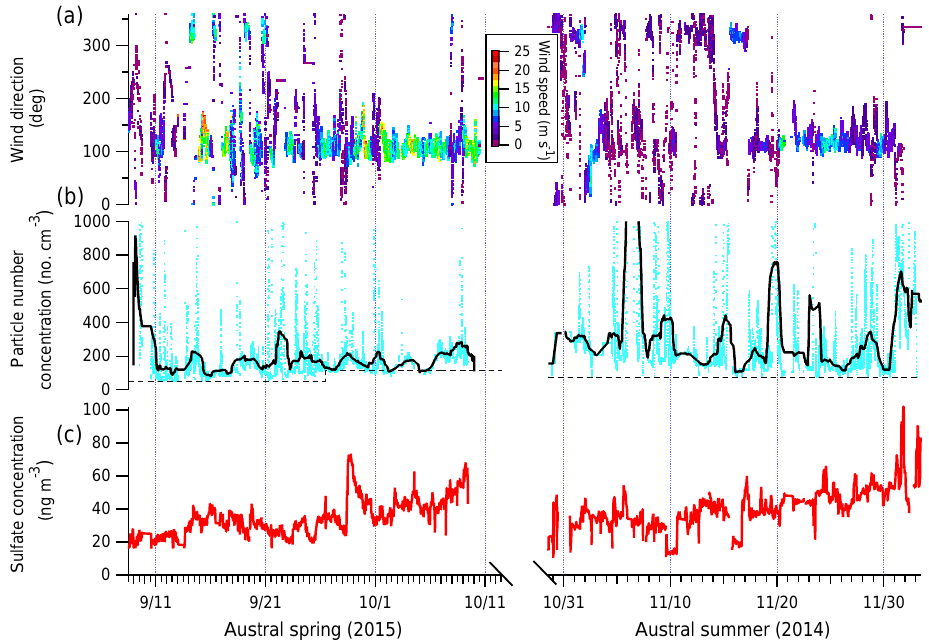
Figure 1. For both the 2014 and 2015 field seasons, with 2015 on the left: (a) wind direction record colored as a function of wind speed, displayed as a 2min average record (standard deviation 0.2ms − 1 and 2 ◦ ); (b) 2min (light blue; standard deviation of 11 and 18cm − 3 for 2015 and 2014, respectively) and 1h (black) records of particle number concentration from the EPC; (c) 2min records of sulfate concentration from the aerosol mass spectrometer. Dotted lines in (b) indicate the minimums in particle number concentrations (99th percentile) measured over the field